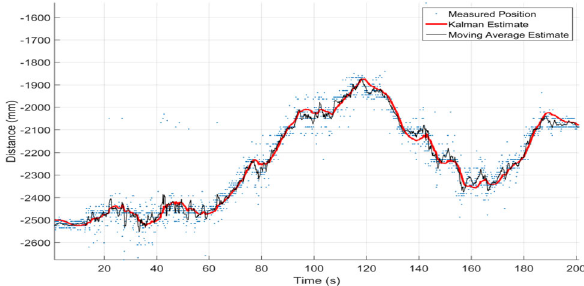
Fig. 13 Creep position estimate, comparison of moving average and Kalman filters based on the filtered versions of the raw radar signal